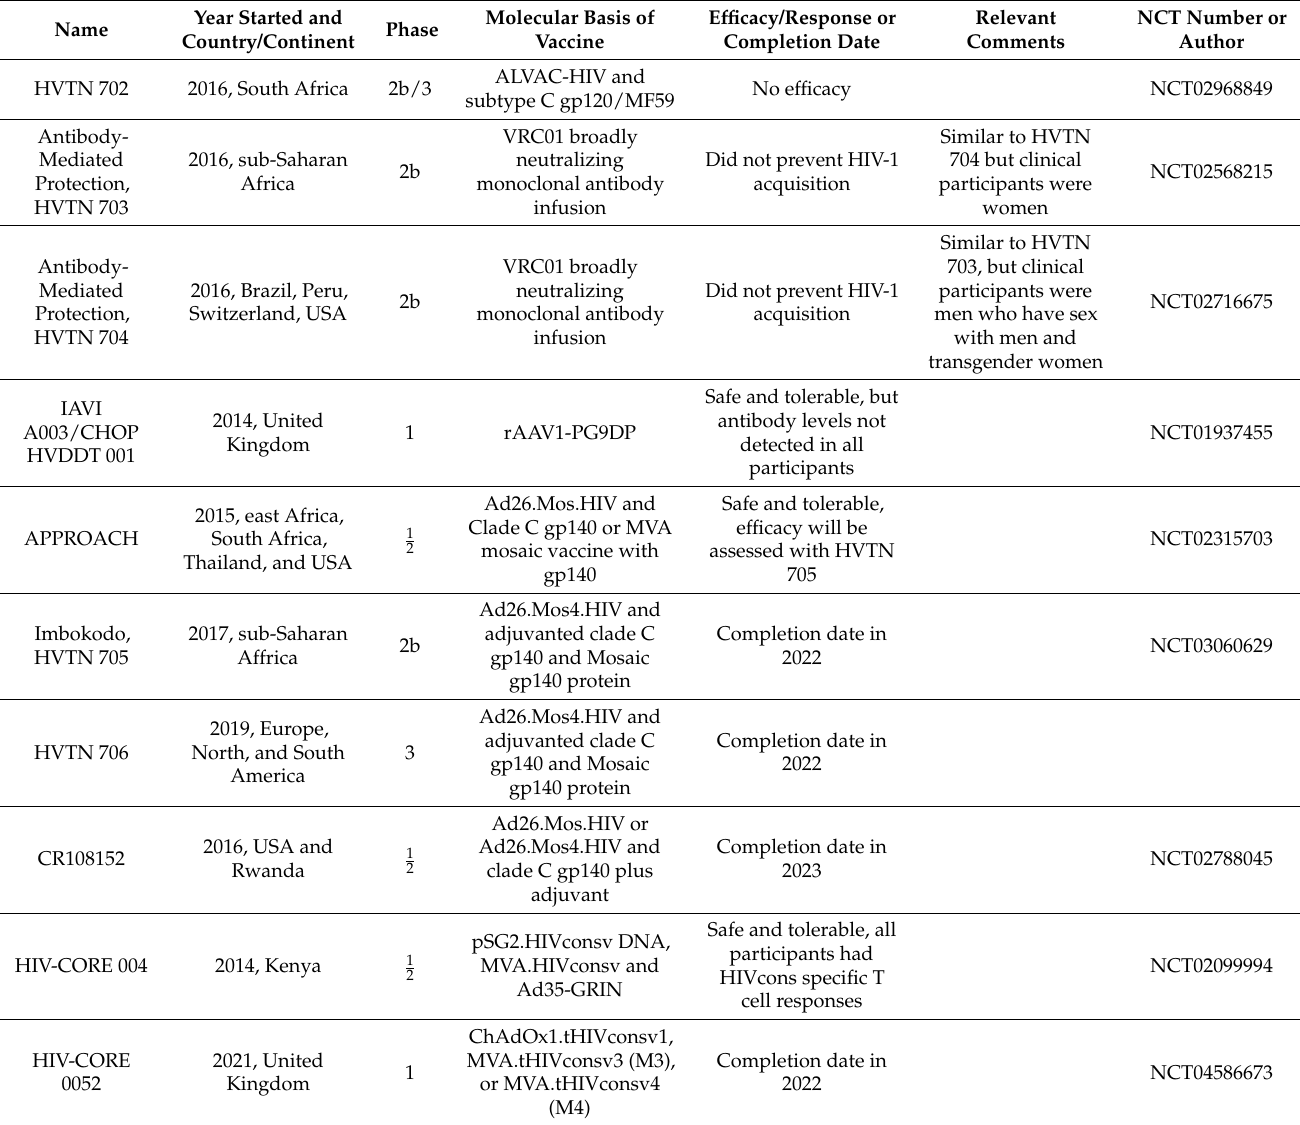
Table 2. Recent and ongoing HIV-1 clinical